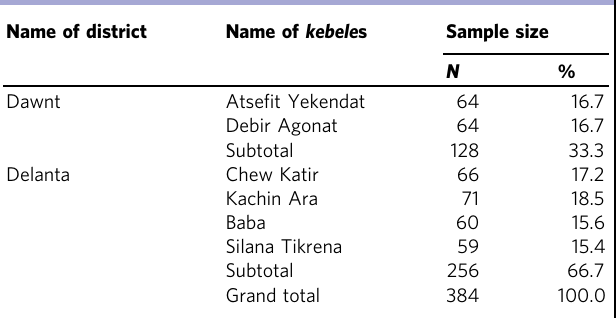
Fig. 3 Wogeltena station mean monthly rainfall (Source: Wogeltena Meteorology Station, mean monthly rainfall of 1981 to 1988). Due to missing data, it was not possible to cover period after 1988 in the analysis. Table 1 Sample HHs by districts and kebeles